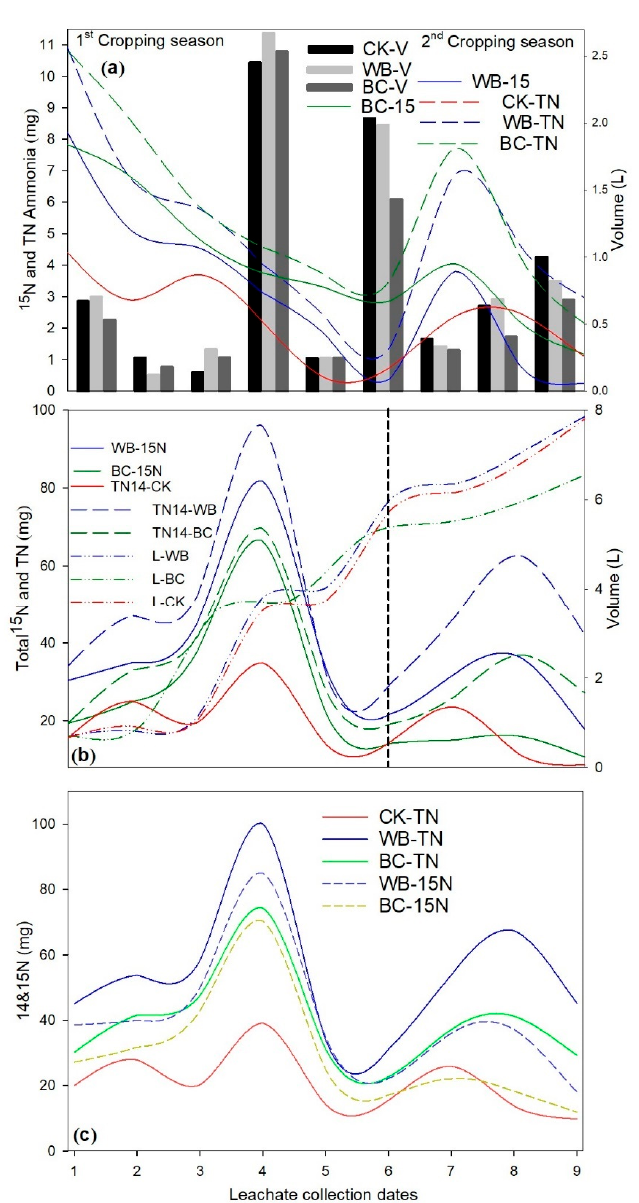
Figure 4. ( a ) Di ff erent 15 N (WB-15 and BC-15) and total N (CK-TN, WB-TN, and BC-TN) ammonia mean levels and leachate mean volumes (CK-V, WB-V, and BC-V) measured on each event as well as cumulated values in lysimeter study against the days after plantation as x-axis for the two cropping seasons of Brassica Camprestis Var. Chinensis in Institute of Environment and Sustainable Development in Agriculture, Chinese Academy of Agricultural Sciences Beijing China. Maximum ammonia levels (labeled and non-labeled) were collected in the first season for all treatments. Moreover, higher ammonia concentrations were collected in BC (biochar added) as compared to WB (without biochar added) and CK (control). ( b ). The mean value of total N ( 14 N + 15 N) nitrate, 15 N nitrate, accumulative volume of leachate in without biochar (L-WB) with biochar (L-BC) and control (L-CK). The maximum total and the 15 N nitrate levels were analyzed in the fourth leachate (maximum volume in all treatments) collected after heavy rain (66 mm). WB presents the more nitrate leaching (total and tracer) as compared to BC and CK in both seasons. Moreover, total volumes collected in all treatments were recorded to be not significantly di ff erent. ( c ). Total mineral N leached in control (CK-TN), biochar added (BC-TN), and without biochar (WB-TN) as well as 15 N leached (WB-15N and WB-15N). Overall, mineral N was leached more in WB as compared to BC in all nine